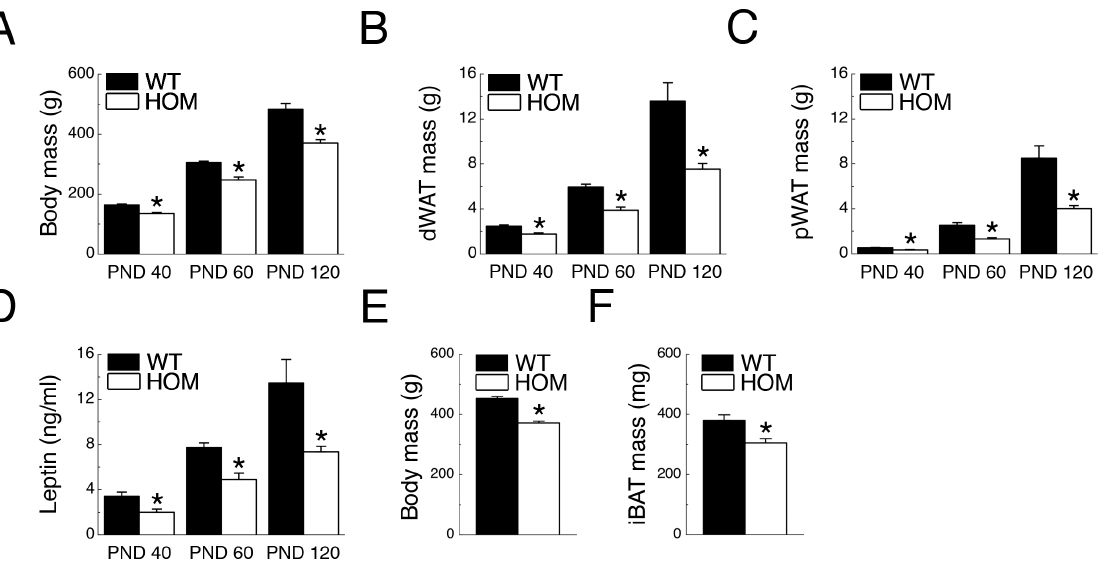
Figure 1. Pmch -deficiency lowers body- and fat mass during development. ( A ) Body mass (BM), ( B ) dWAT mass, ( C ) pWAT mass, and ( D ) serum leptin concentrations in WT and HOM rats (n=8–15/group) at postnatal (PND) days 40, 60, and 120, and ( E ) body mass and ( F ) iBAT mass in WT and HOM rats (n=15–19/group) at PND 147. * P , 0.05 vs WT.